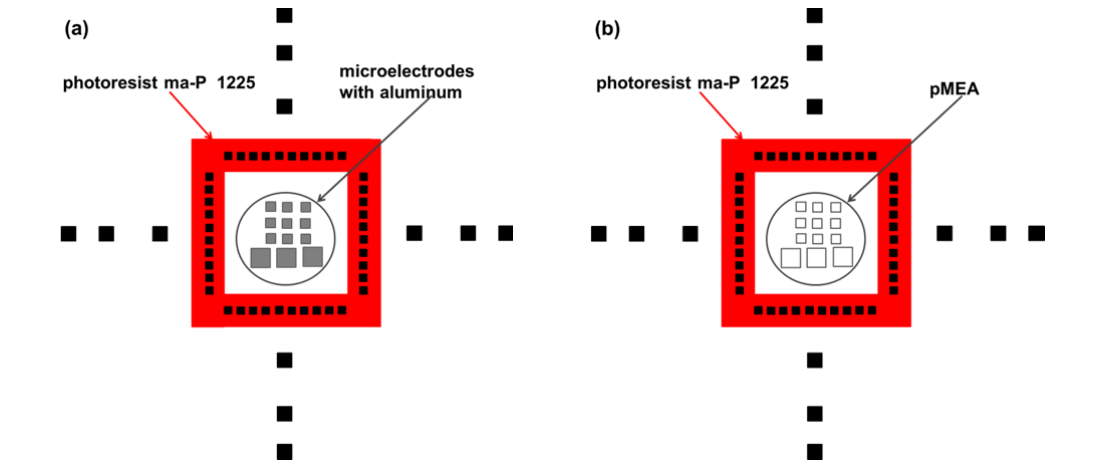
Figure 7. Positive photoresist deposited over the bondpads and microelectrodes with (a) aluminum and (b) without